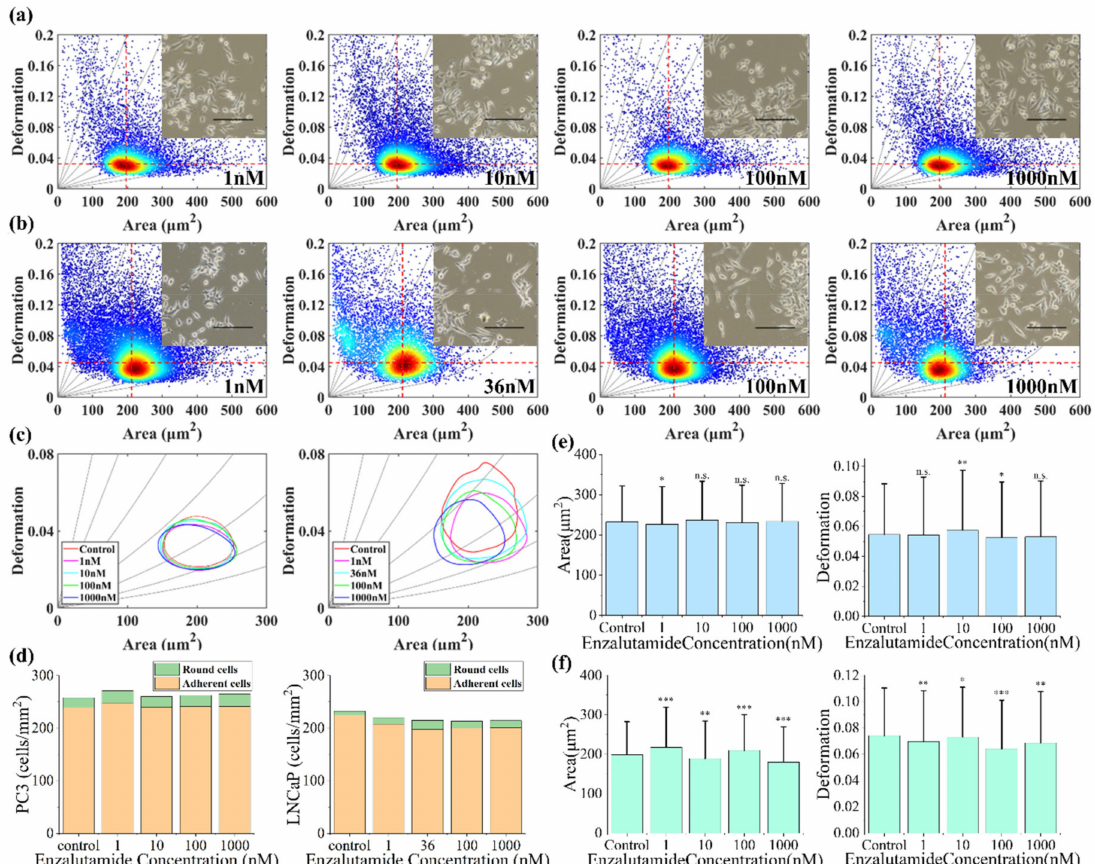
Figure 6. ( a ) The deformation versus area scatter plots of PC-3 cells cultured in cell medium containing different enzalu- tamide concentrations after 24 h. ( b ) The deformation versus area scatter plots of LNCaP cells cultured in cell medium containing different enzalutamide concentrations after 24 h. The order is 1 nmol/L, 10 nmol/L, 100 nmol/L and 1 µ mol/L. ( c ) The 50% density contour line of different enzalutamide concentrations on PC-3 and LNCaP cells. ( d ) Quantity trends of round cells and adherent cells in PC-3 and LNCaP cells. ( e ) The average degree of PC-3 cell area and deformation under different enzalutamide concentrations. ( f ) The average degree of LNCaP cell area and deformation under different enzalutamide concentrations. The *, **, *** and n.s. indicate p values of less than 0.05, 0.01, 0.001, 0.0001 and more than 0.05, respectively. The red dotted lines for references represent the median of the control group PC-3 and LNCaP cells’ cross-sectional area and deformation, respectively. The inset shows the optical microscopic images of untreated control group and enzalutamide-treated prostate cancer cell line. The scale bar represents 200 µ